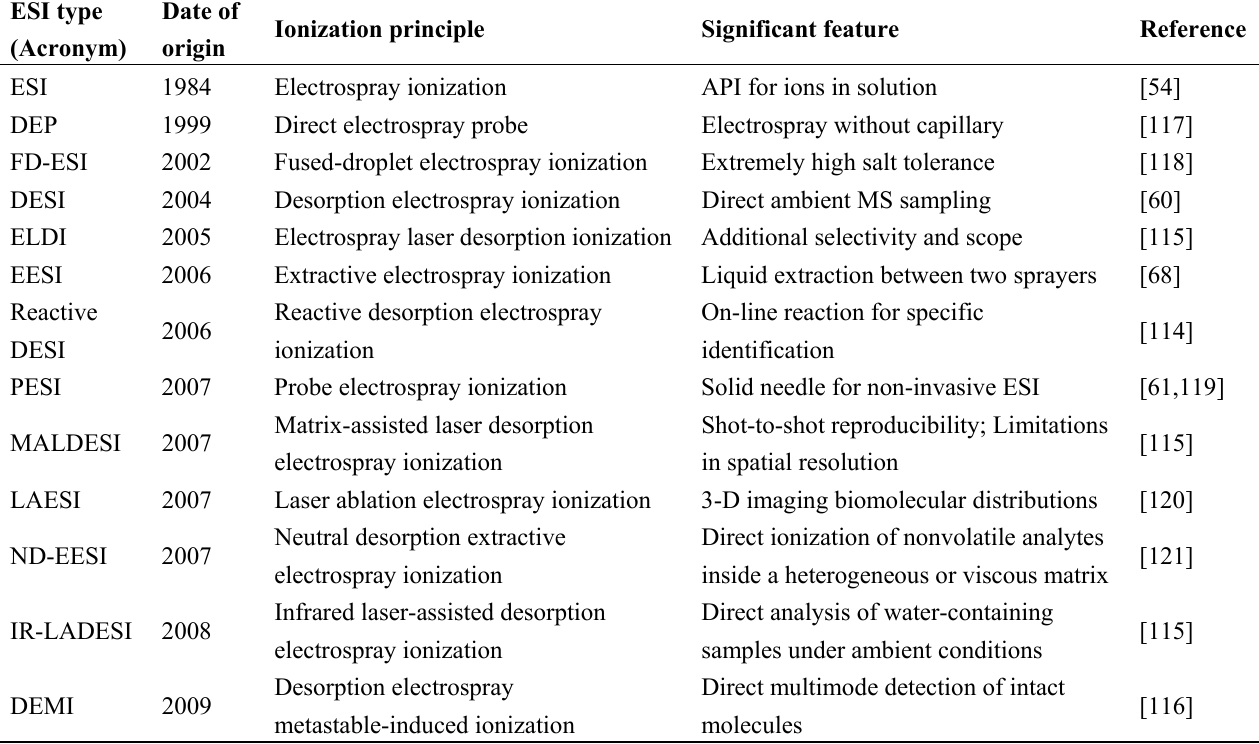
Table 2. Glossary of different ESI-related methods listed in order of publication. Abbreviations for full name of ionization techniques and references to the original work are provided within the